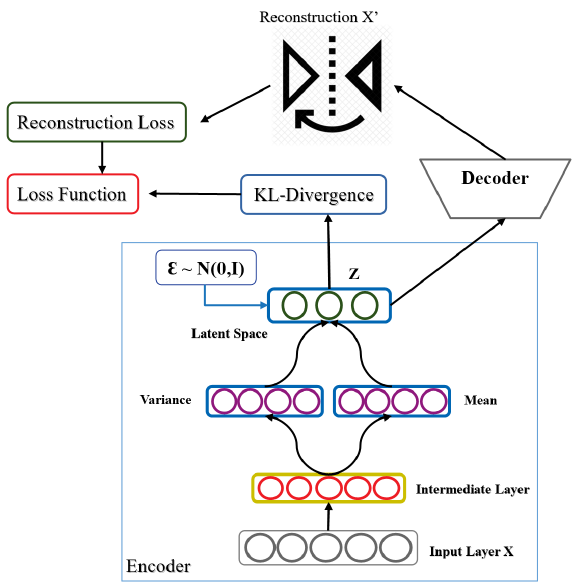
Figure 2. Reconstruction loss and Kulback-Leibler (KL) divergence to train